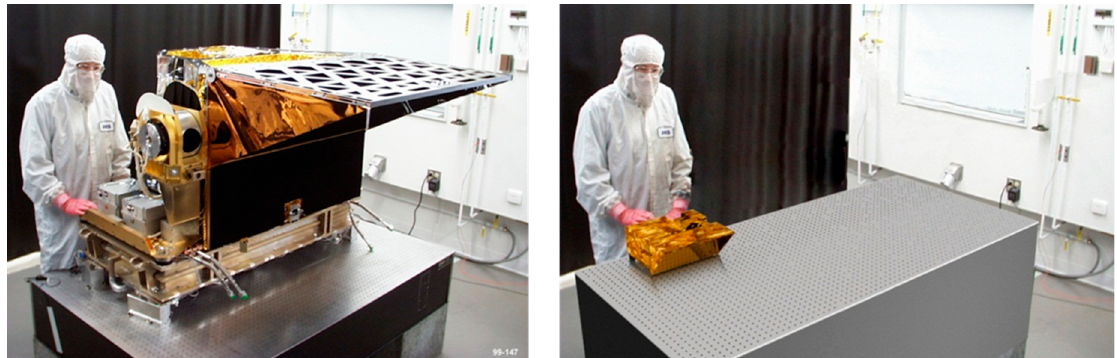
Figure 6. A combination of key requirements changes (focusing on tropospheric sounding), instrument design innovation and key technology advances enable a dramatic reduction in instrument size between AIRS instrument ( left ) and MISTiC , shown as an artist’s concept ( right ). Table 1. Key MISTiC instrument requirements.